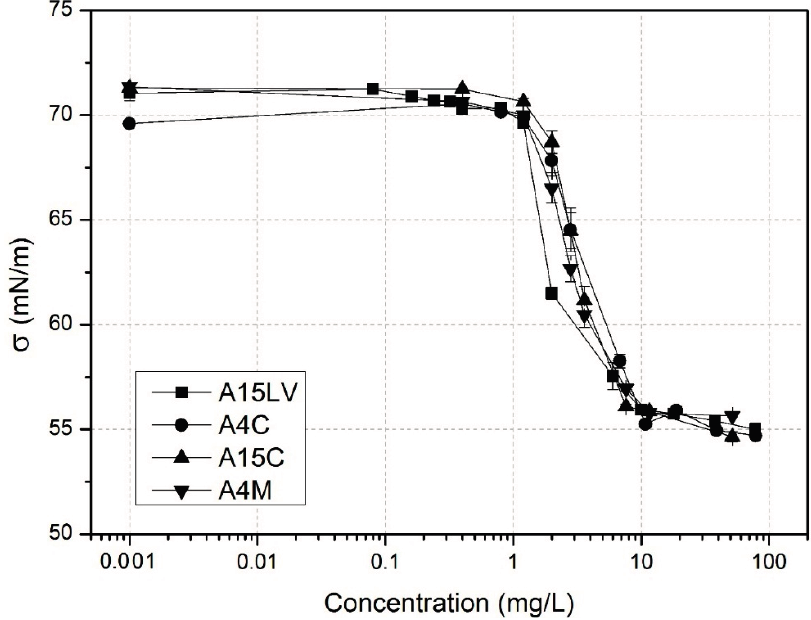
Figure 4. Influence of the molar mass on the tensio-active properties ( σ in mN/m) of methylcellulose as a function of polymer concentration expressed in mg/L at 20 °C.